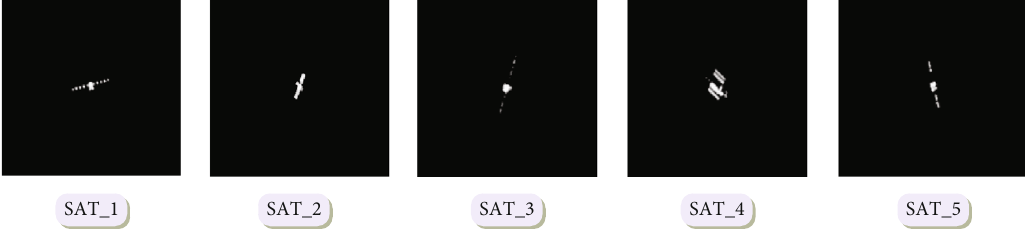
Figure 15: The segmentation and normalization results of ISAR images of the fi ve types of space